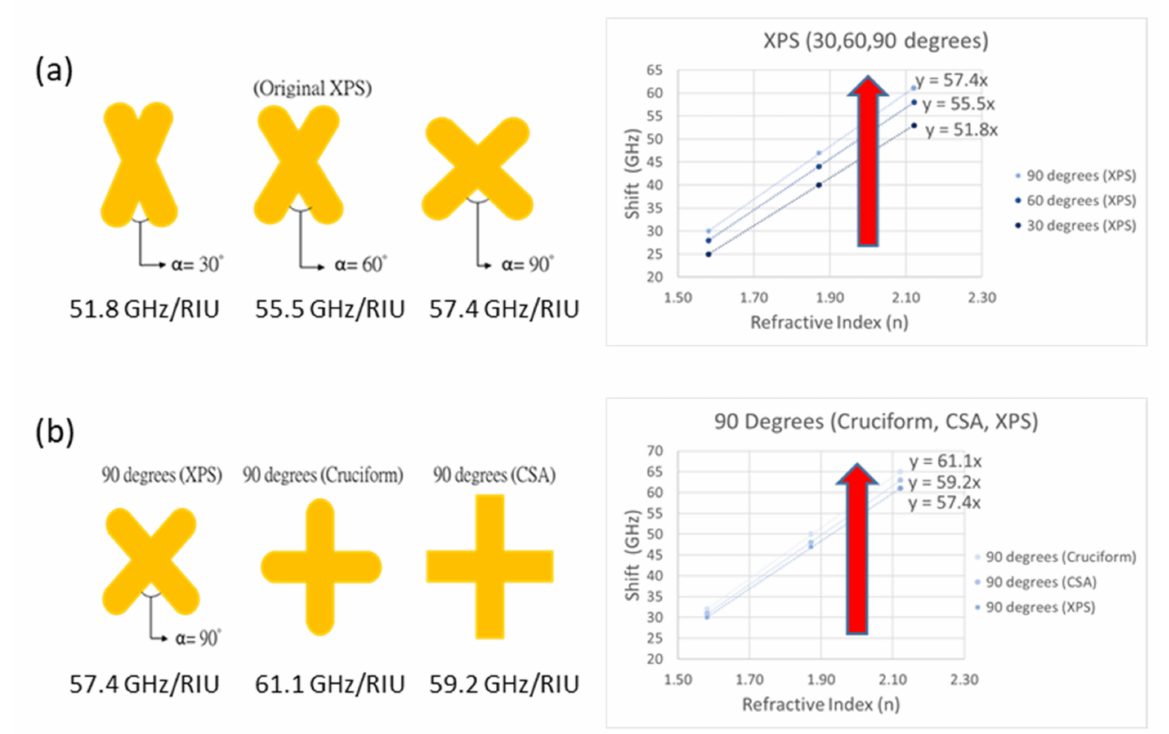
Figure 4. ( a ) Sensitivity of XPS (30, 60, 90 degrees). ( b ) Sensitivity of 90 degrees (XPS, Cruciform,